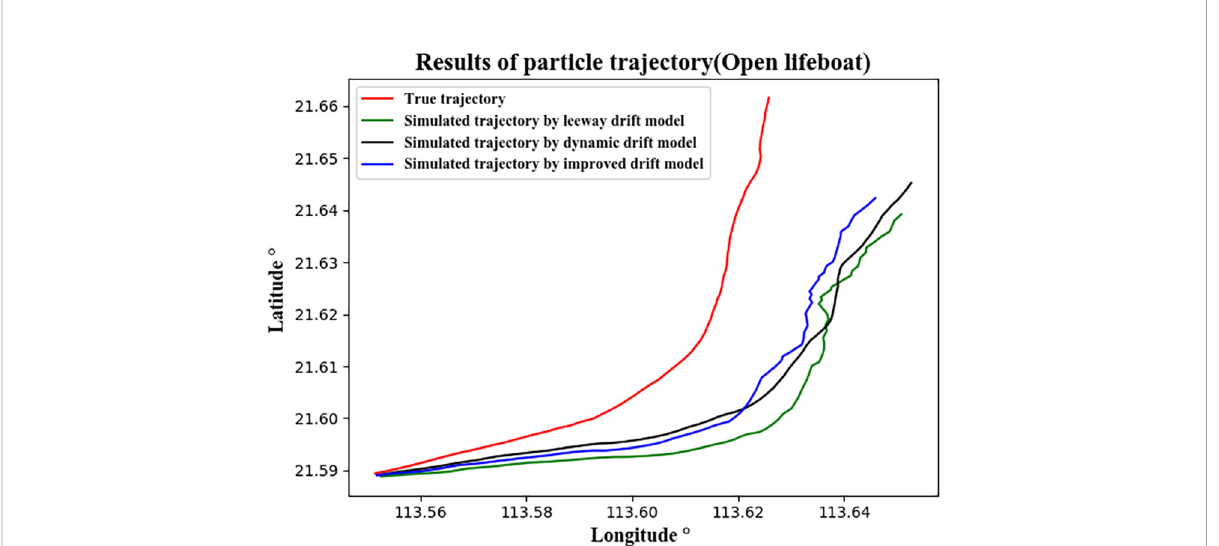
FIGURE 12 The true trajectory and the simulated trajectories using the Lagrangian particle tracking method for the open lifeboat in Case 2. The red line represents the true trajectory, and the green, black and blue lines represent the trajectories simulated by the leeway drift model, the dynamic drift model and the improved drift model, respectively.